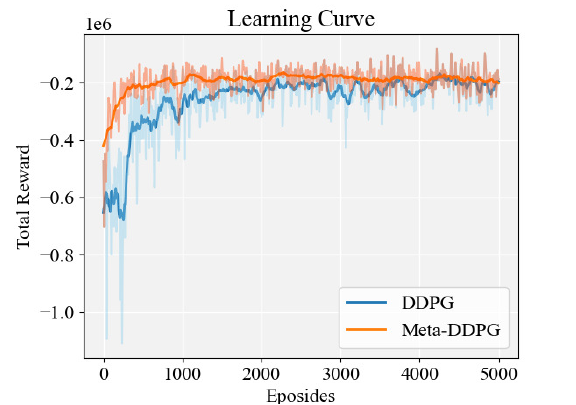
Figure 5. The total rewards’ trend in the